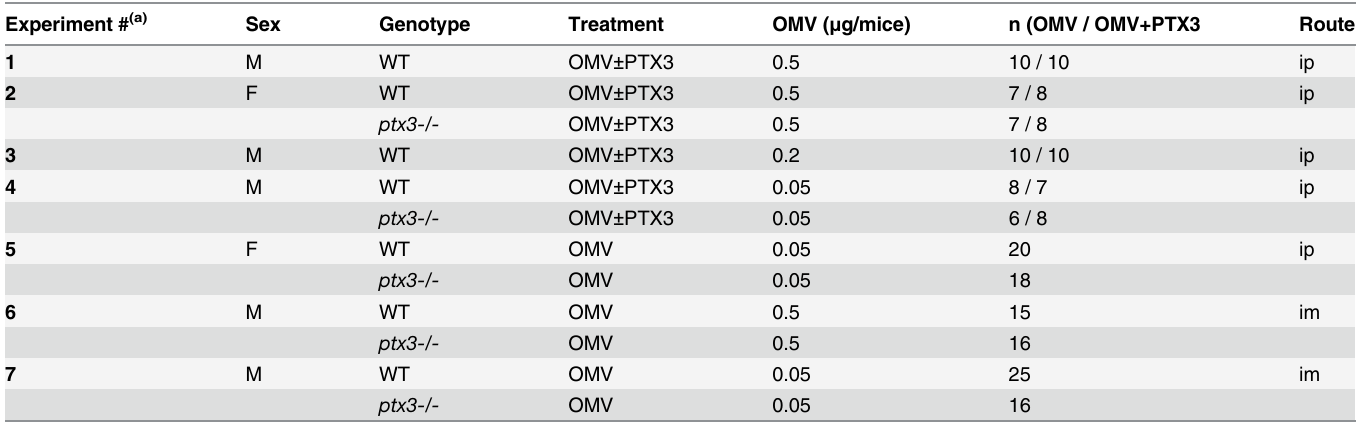
Table 1. List of immunization experiments. Experiment # (a)